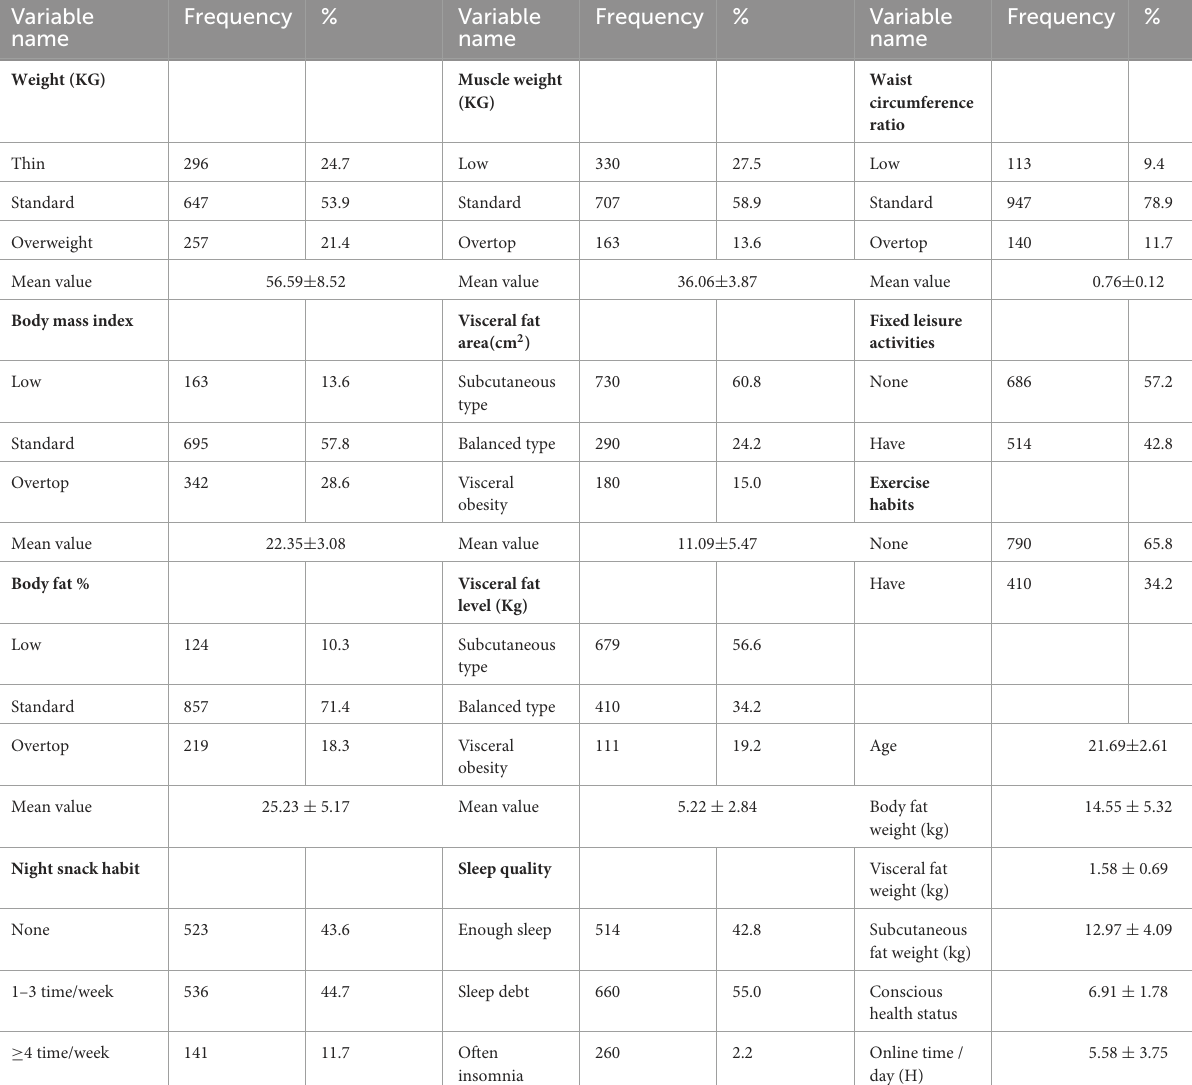
TABLE 2 Statistical table of basic information and physical condition of respondents ( N = 1,200).